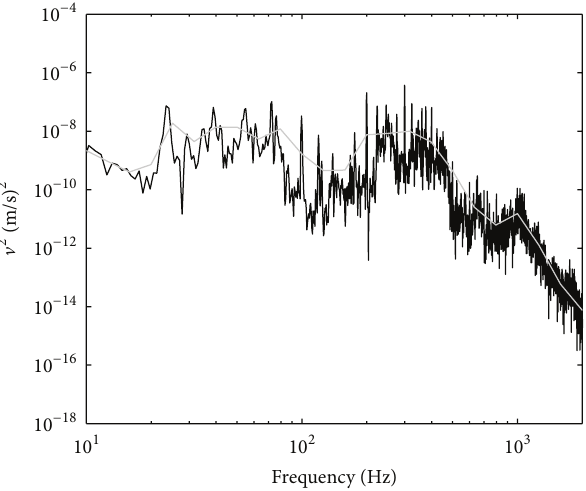
Figure 6: The measured spatially average mean-squared velocity of the high mobility reception plate (grey line: one-third octave